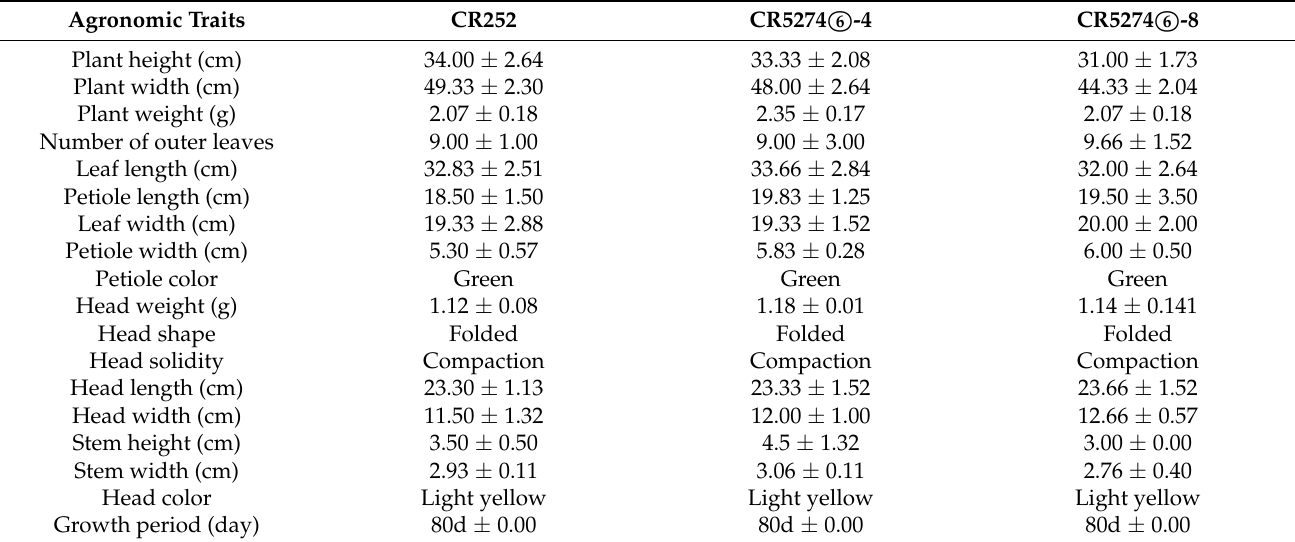
Table 6. Agronomic-trait investigation of recurrent parent and pyramided lines.